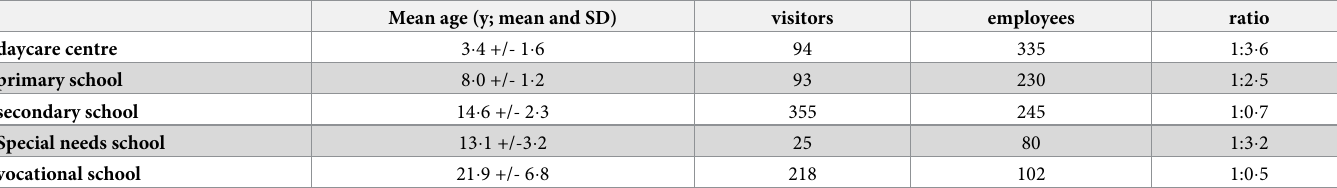
Table 4. Number of infections in educational institutions.